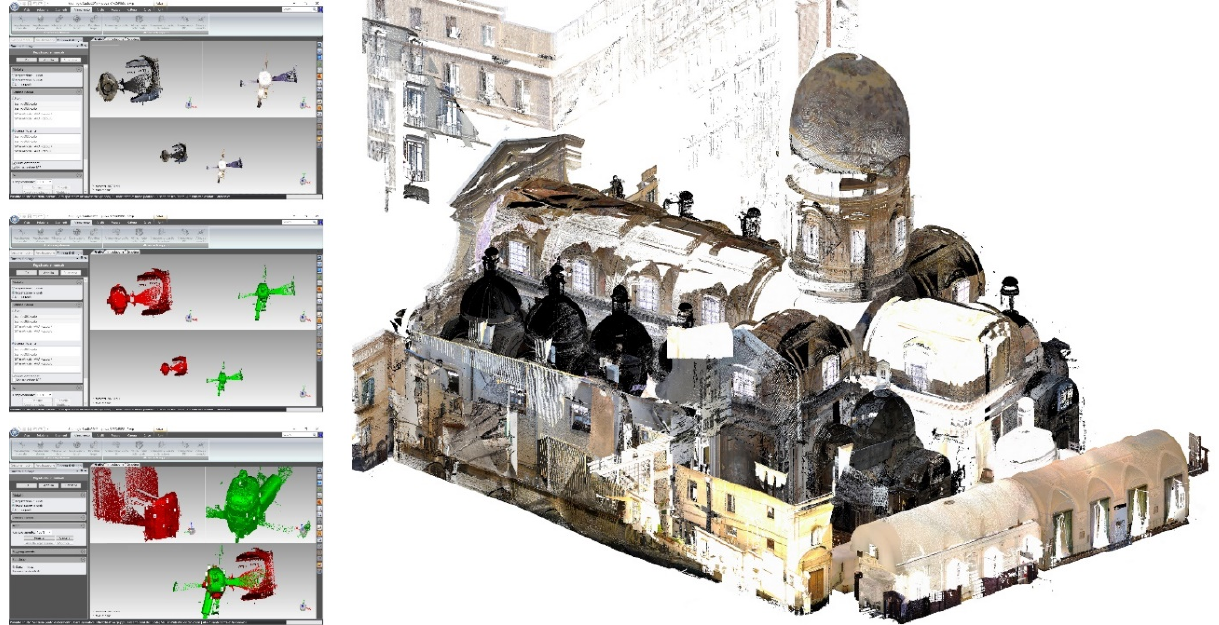
Figure 12. Integration of range-based models into the Geomagic Studio